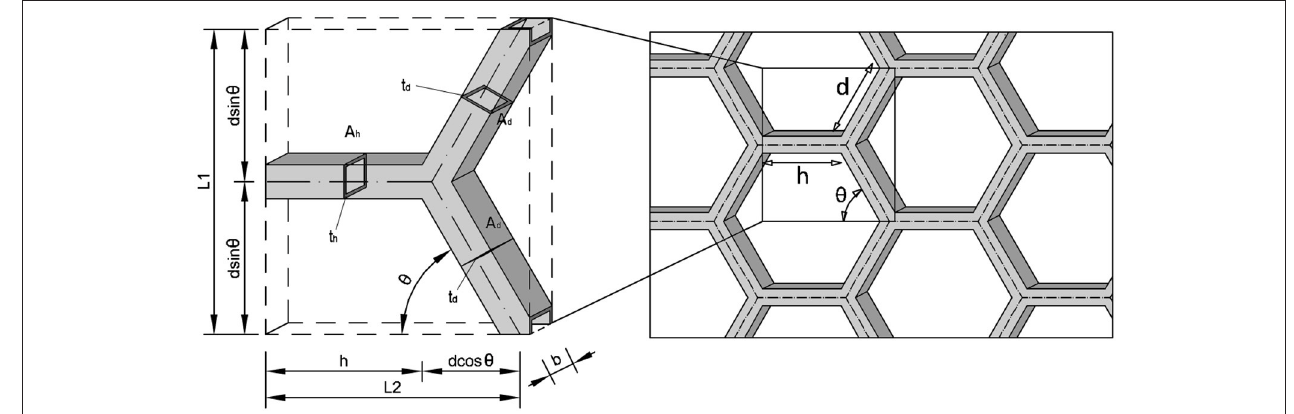
FIGURE 5 | Regular Voronoi with horizontal grid and definition of the unit cell.